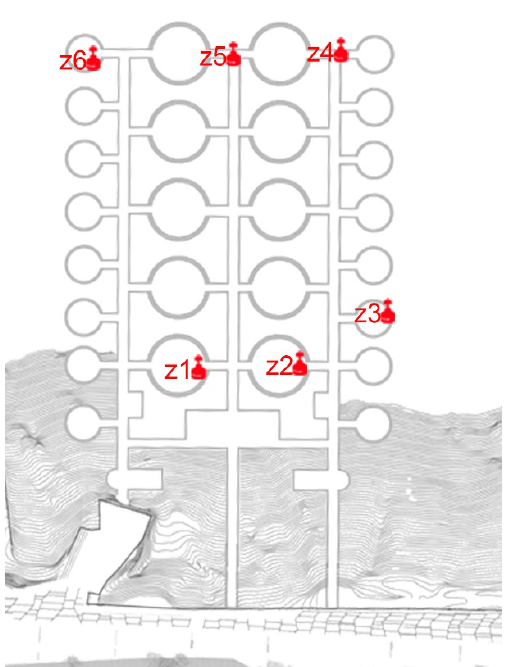
Figure 16. Plan view of the placement of the measurement devices inside the old